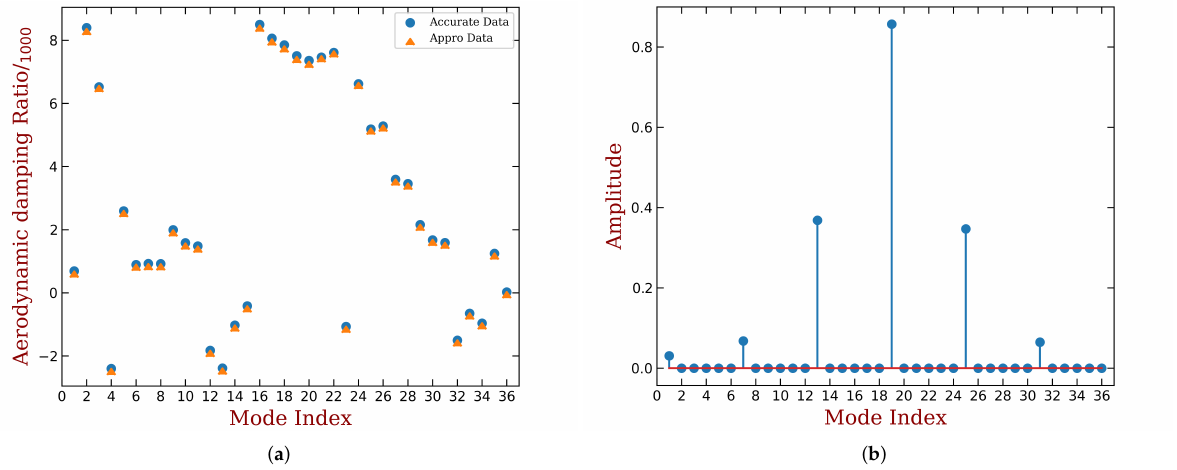
Figure 8. Interpreting the aeroelastic damping with h = 6 wave mistuning. The mistuning modes are sorted by natural frequencies in ascending order. The mapping between the tuned modal index and NDI is shown in Equation (4). ( a ) Damping ratio reconstructed by Equation (29), ( b ) the weight of tuned modes to the least damping mistuning